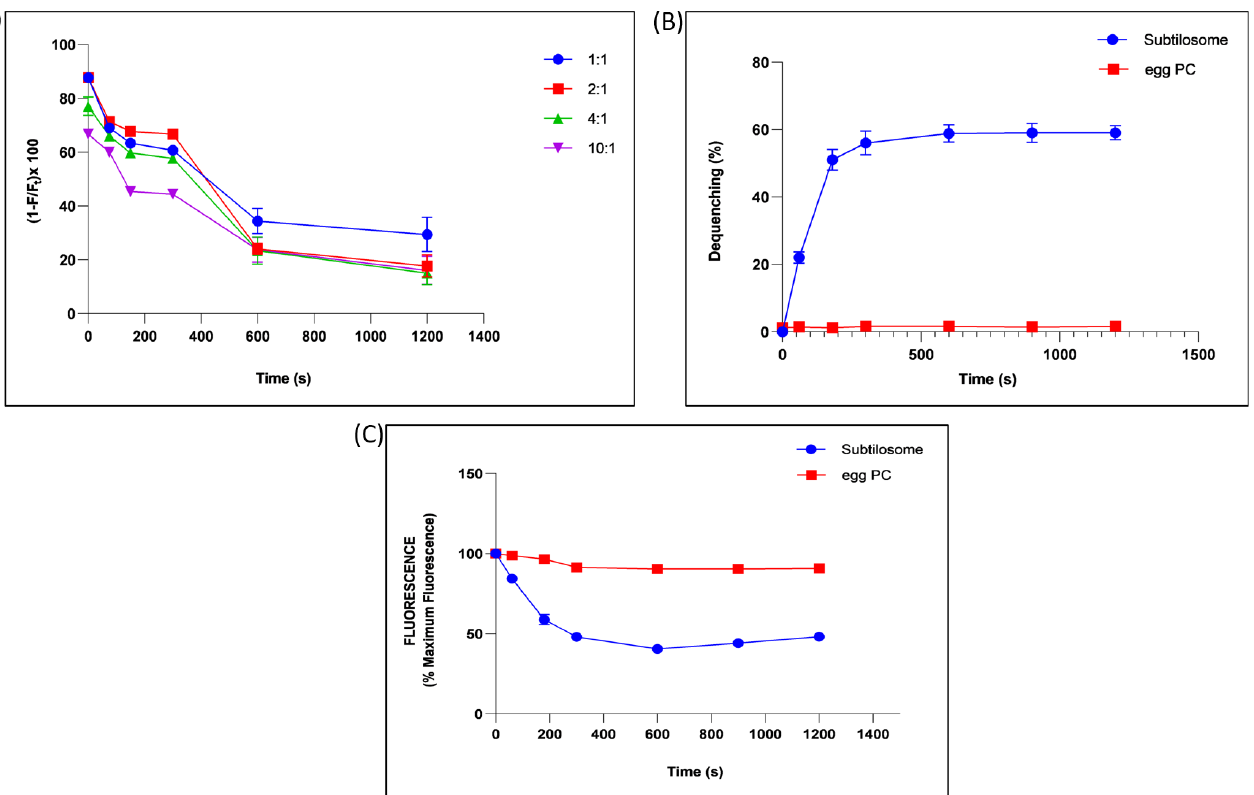
Figure 3. Fusogenic property of subtilosome. ( A ) Time-dependent effect on the efficiency of FRET between NBD and rhodamine grafted on the subtilosome surface upon mixing the labelled subtilo- somes with increasing amounts of unlabelled subtilosomes (labelled-to-unlabelled ratios were taken as 1:1, 1:2, 1:4, 1:10). ( B ) Interaction of Rh-PE-labelled subtilosomes or egg-PC liposomes with their unlabelled counterparts. Subtilosomes or egg-PC liposomes containing 5 mol% Rh-PE were allowed to interact with unlabelled form of the same types of the vesicles in a ratio of 1:10. The fluorescence associated with the labelled subtilosomes or egg-PC liposomes was monitored for up to 20 min using excitation and emission wavelengths of 536 and 585 nm, respectively. ( C ) Time-dependent quenching of the ANTS fluorescence by mixing the ANTS-containing subtilosomes or egg-PC liposomes with DPX-containing subtilosomes or egg-PC liposomes in a ratio of 1:10. The excitation and emission wavelengths used were 380 and 540 nm, respectively. Values are the means of three independent experiments ±